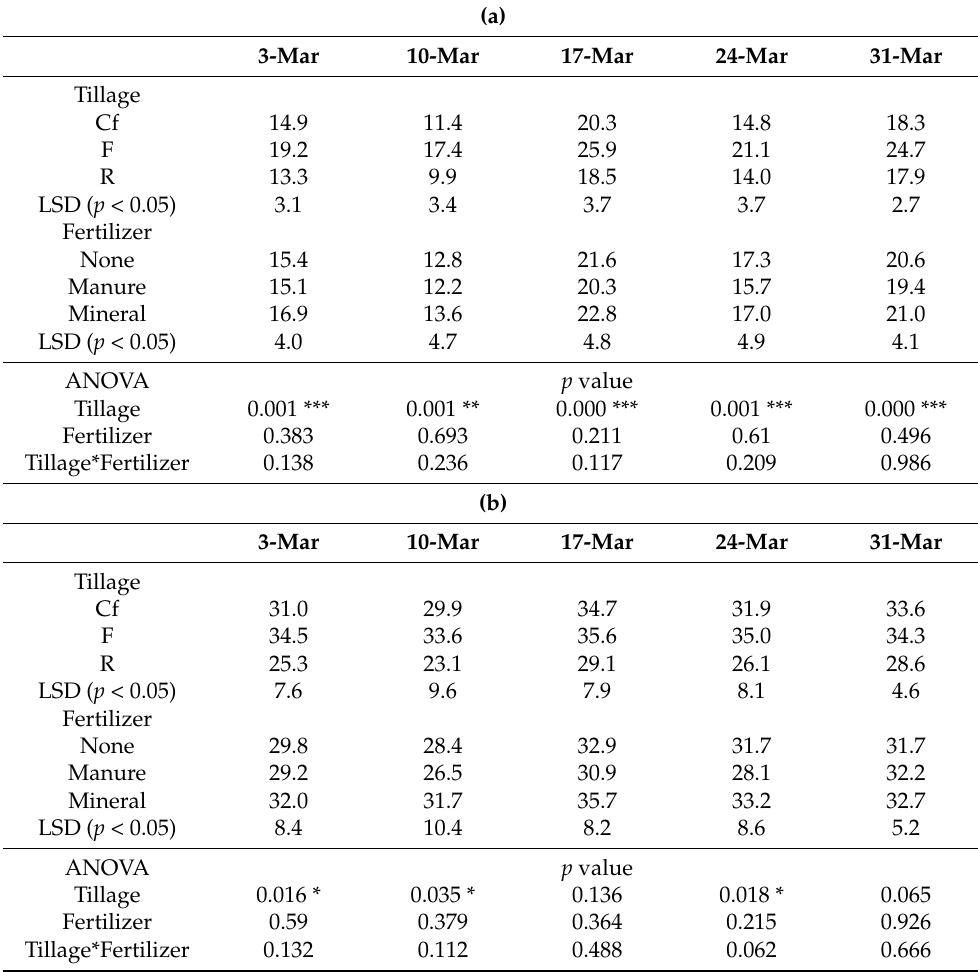
Table 5. Gravimetric soil moisture (g water/g dry soil) at depths of (a) 10–20 cm and (b) 30–40 cm during March